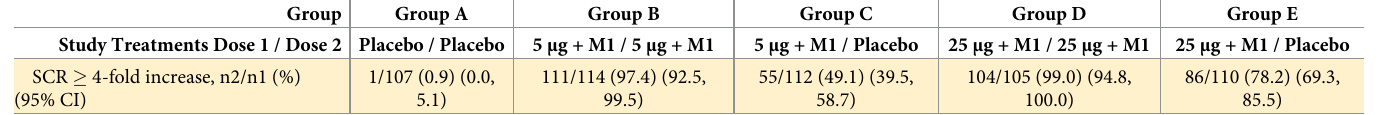
(Day 21) with 5- μ g NVX-CoV2373 (Groups B and C combined) and 25- μ g NVX-CoV2373 (Groups D and E combined), anti-spike protein binding IgG GMTs were higher for younger participants than older participants (Table 2). Seroconversion rates were also higher for youn- ger participants (79% and 93% for 5- μ g first doses and 25- μ g first doses, respectively, and 43% and 75% for older participants by dose, respectively).